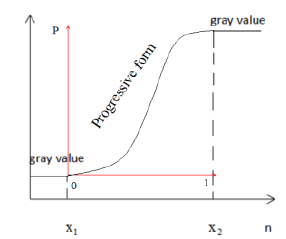
Figure.2 schematic of trigonometric functin graduation algorithm